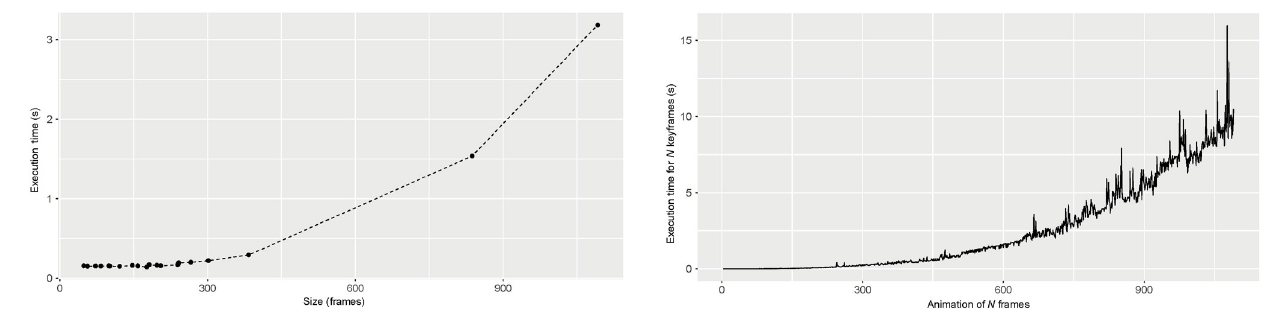
Fig. 16 Execution time versus the number of frames in the animation. The horizontal axis gives the number of frames in the animation, while the vertical axis gives the time required to find all optimal solutions using an Intel Core i7-8700 @ 3.20 GHz. To generate these results, we ran Salient Poses on slices of the “Samba Dancing” example. One slice includes the first three frames, another the first four frames, and so on, with the last slice containing all 1092 frames. Extrapolating the graph shows a cubic trend between the number of frames and execution time, which reflects the O ( N 3 ) complexity of our algorithm described in Section